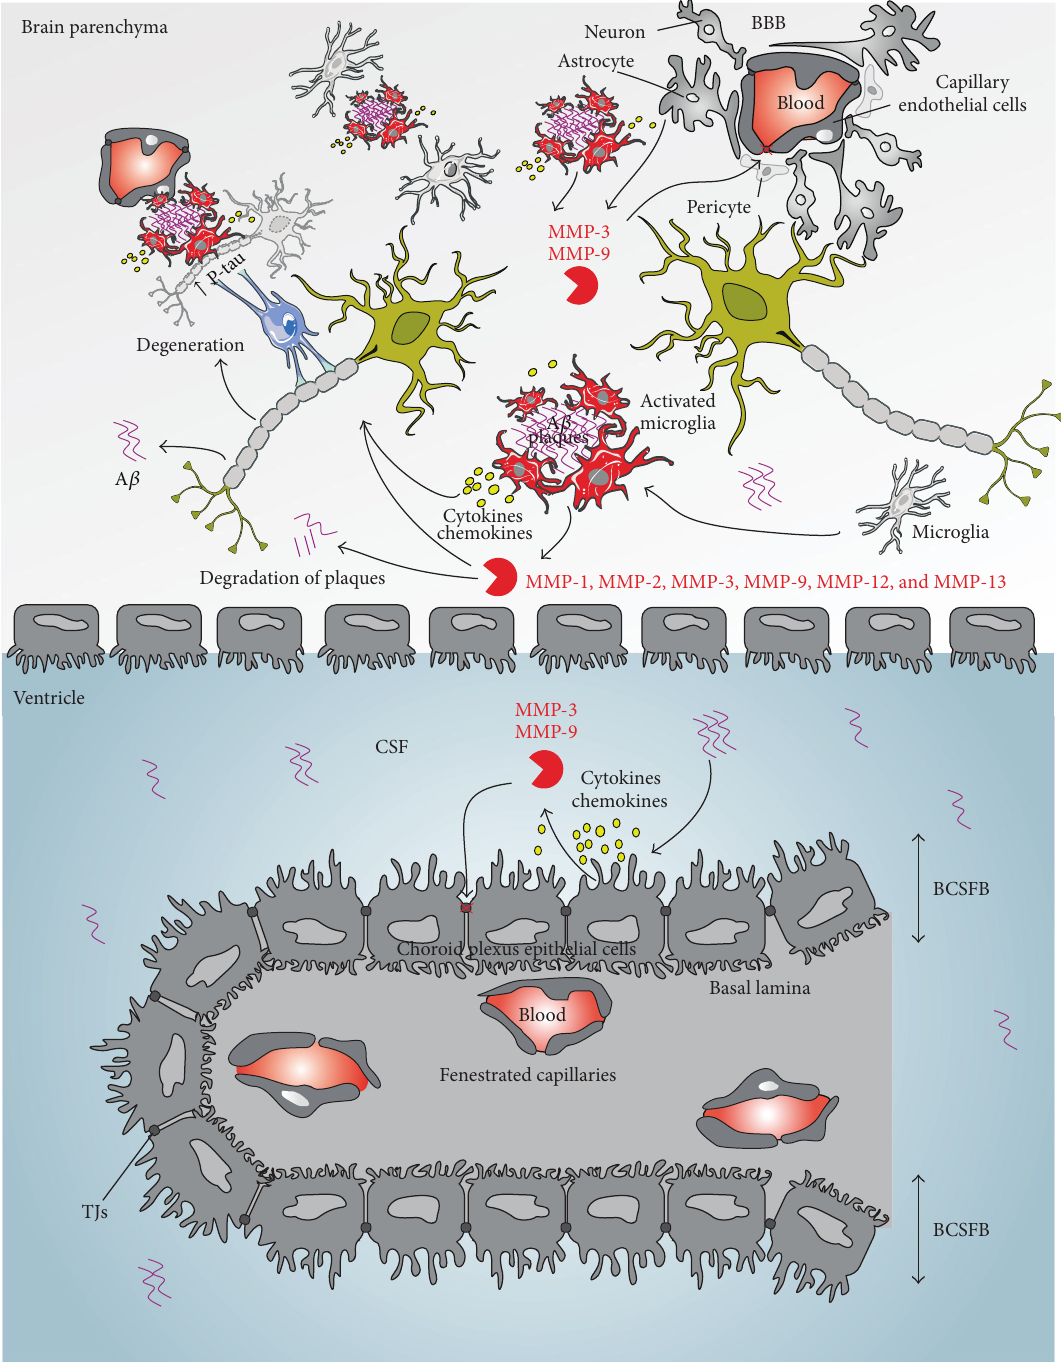
Figure 3: Schematic representation of the involvement of MMPs in Alzheimer’s disease pathology. A 𝛽 peptides produced from APP processing form oligomers that subsequently form amyloid deposits or plaques in the brain parenchyma. A 𝛽 oligomers activate inflammatory cellsinthebrain(astrocytes,microglia,andchoroidplexusepithelium).Onceactivated,microgliachangetheirshape,migrateclosetoplaques, and begin to secrete proinflammatory cytokines and MMPs. Secreted MMPs degrade A 𝛽 and, on the other hand, exacerbate inflammation in thebrain, leading to death of neurons. Thesecytokines and MMPsalso affect theendothelial tight junctions, alter thepericyte phenotypes, and contribute to increased BBB permeability. Similarly, oligomers in the CSF activate the choroid plexus epithelium, which leads to the release of proinflammatory cytokines and MMPs. These secreted MMPs further damage the tight junctions at the BCSFB. A 𝛽 , 𝛽 -amyloid; BBB, blood-brain barrier; BCSFB, blood-cerebrospinal fluid barrier; CSF, cerebrospinal fluid; MMP, matrix metalloproteinase; TJs, tight